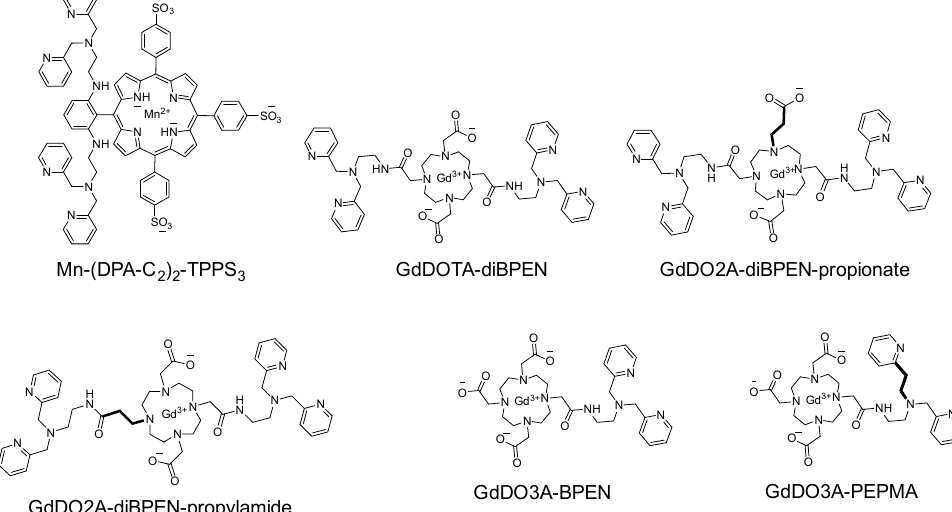
Figure 4. Chemical structures of some zinc-responsive MRI contrast agents applied in vivo . The typical strategy for creating these agents is to add a zinc-responsive N , N -bis(2-pyridyl-methyl)ethylenediamine (BPEN) ligand to the macrocyclic ring. Altering the alkane chain linking nitrogen atoms alters the binding constants of zinc, resulting in different responsiveness.